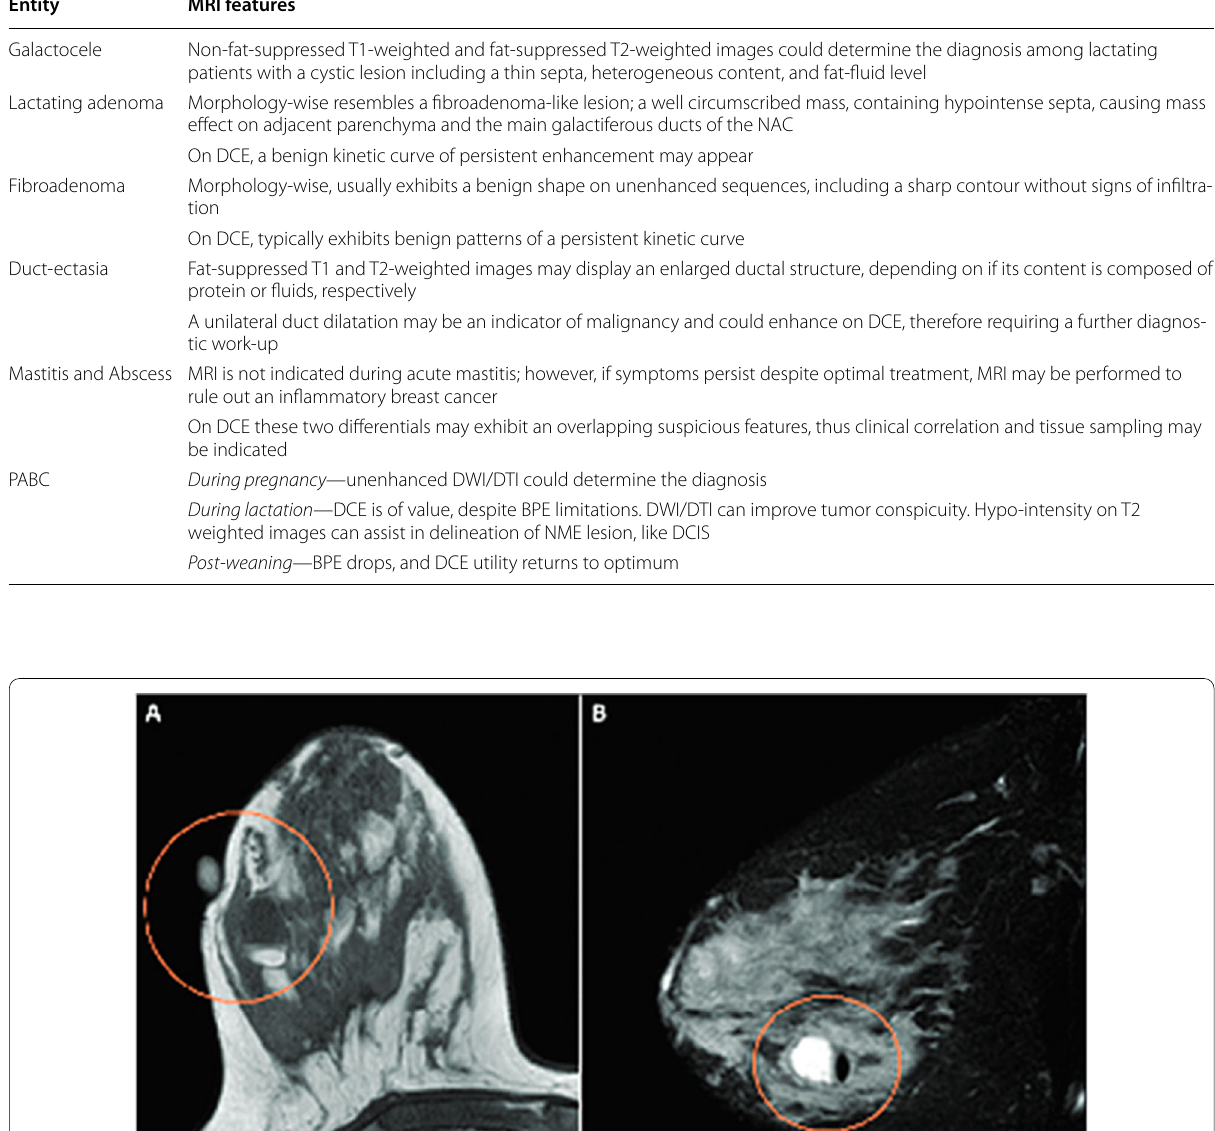
Table 1 A summary of the MRI features of common breast entities during pregnancy and lactation Entity